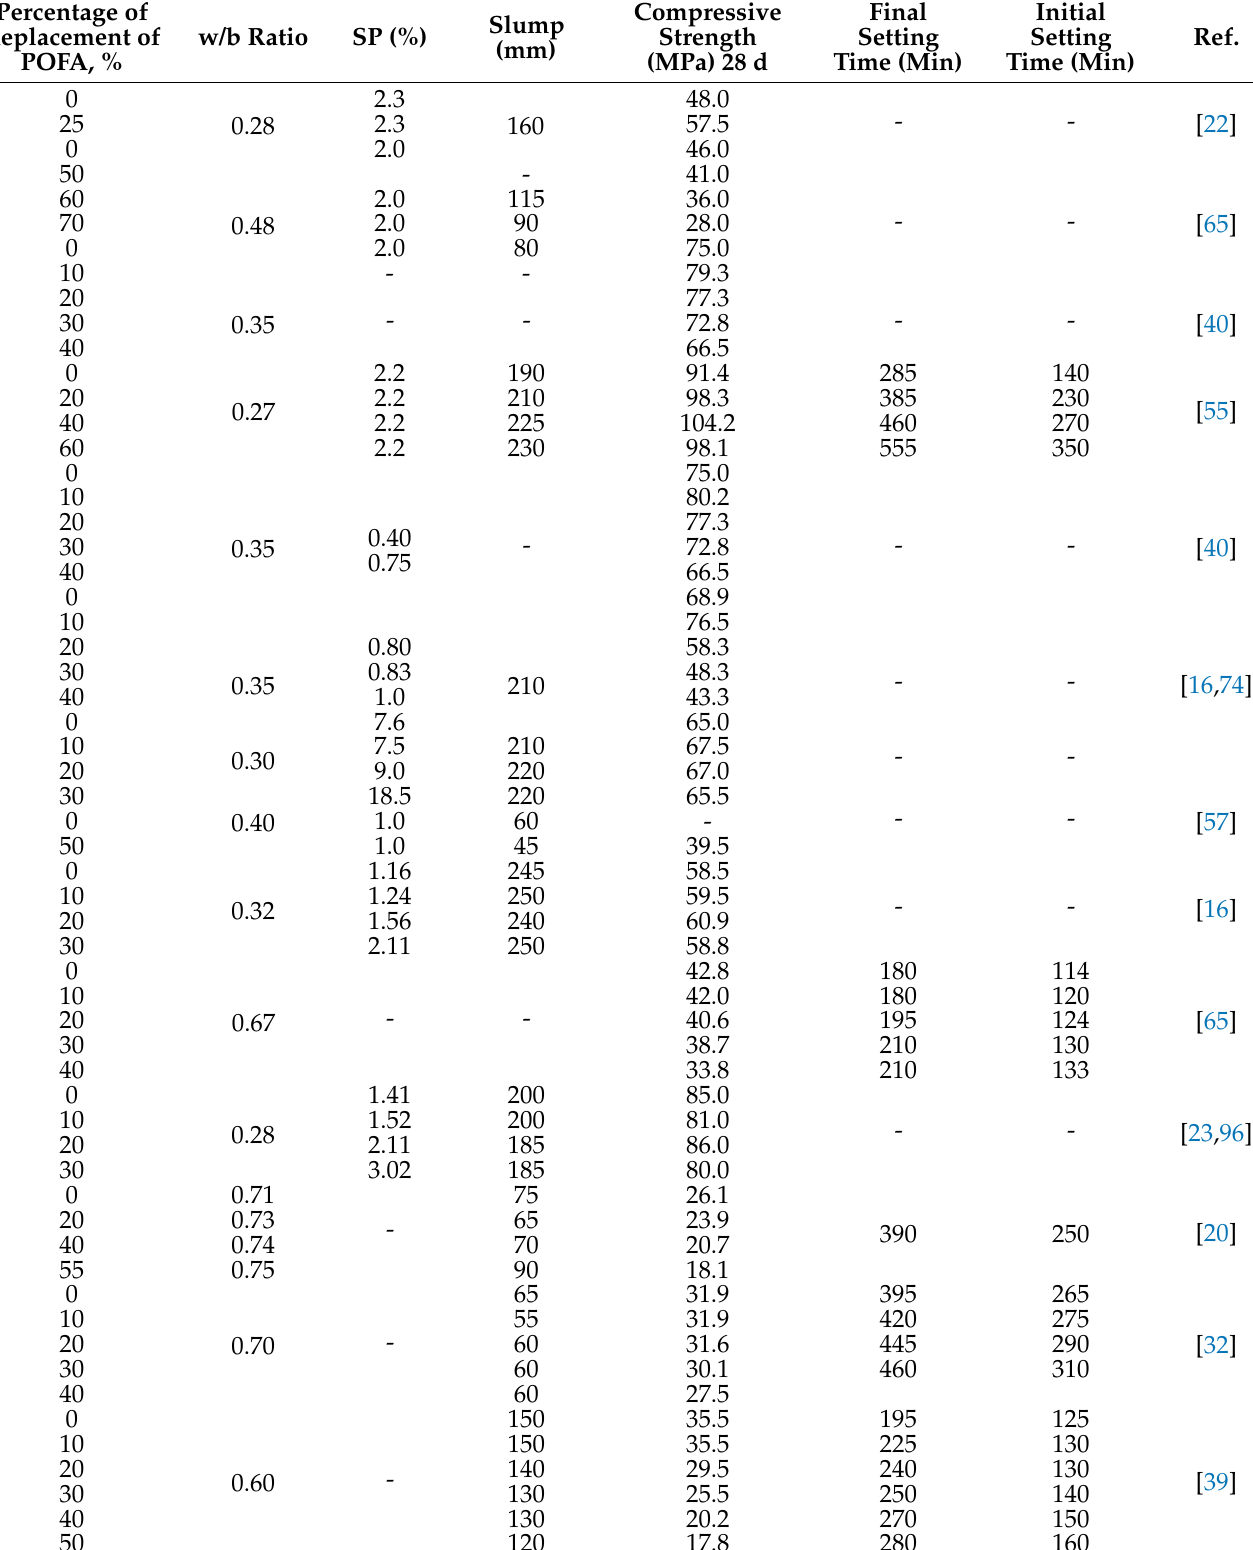
Table 11. Compressive strength with different setting